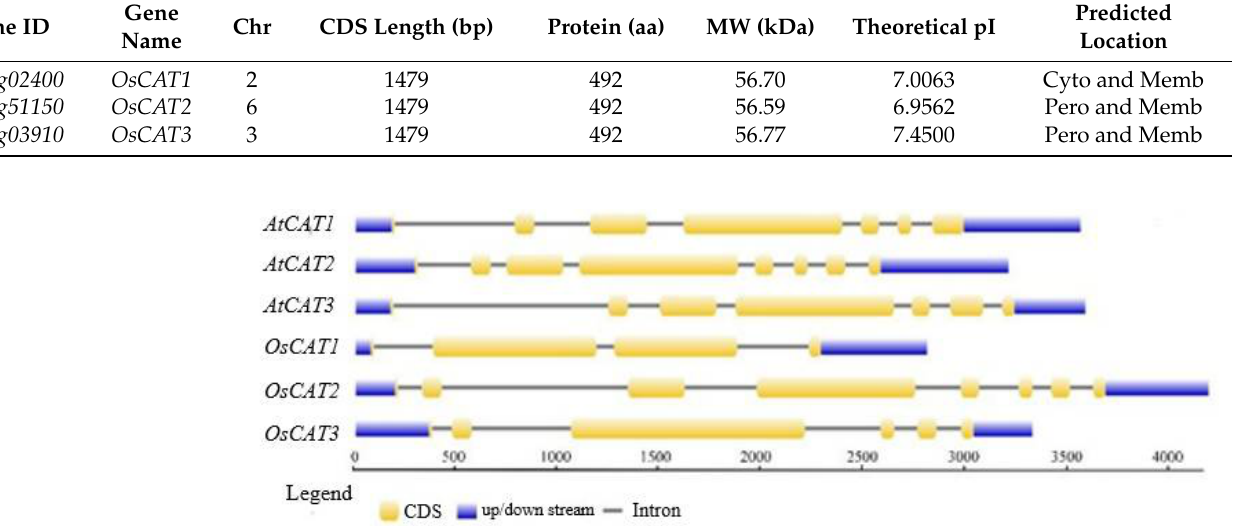
Table 1. CAT gene and coding protein information.